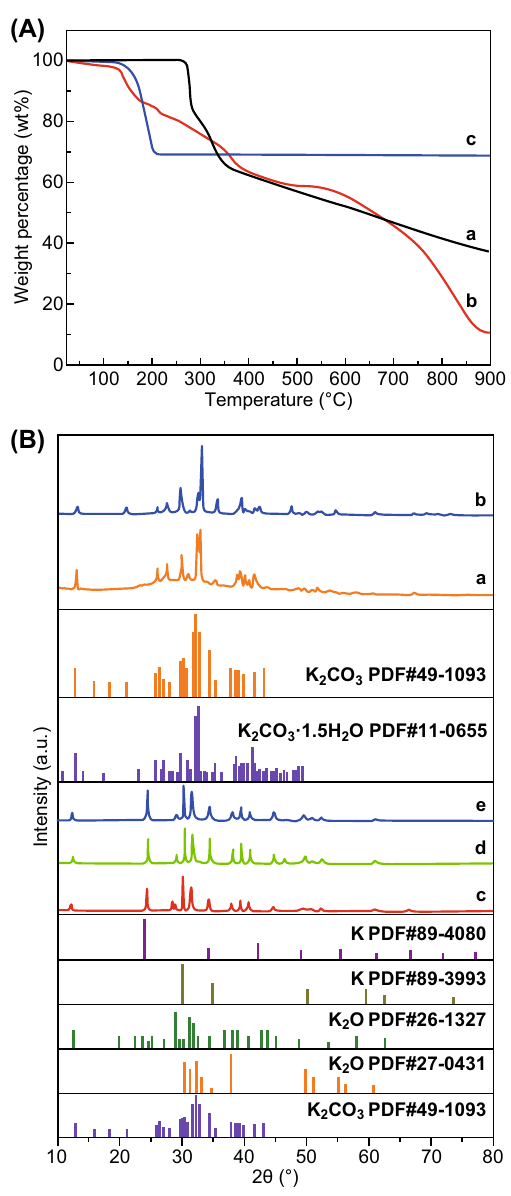
Fig. 1 A TG curve under N 2 of the pure His (a), PBC/His mixture with a molar ratio of 2.0 (b) and pure PBC (c). B Wide-angle XRD patterns of the composites obtained by heating the PBC/His mix- ture with a molar ratio of 2.0 at 400 (a), 600 (b), 700 (c), 800 (d) and 900 °C